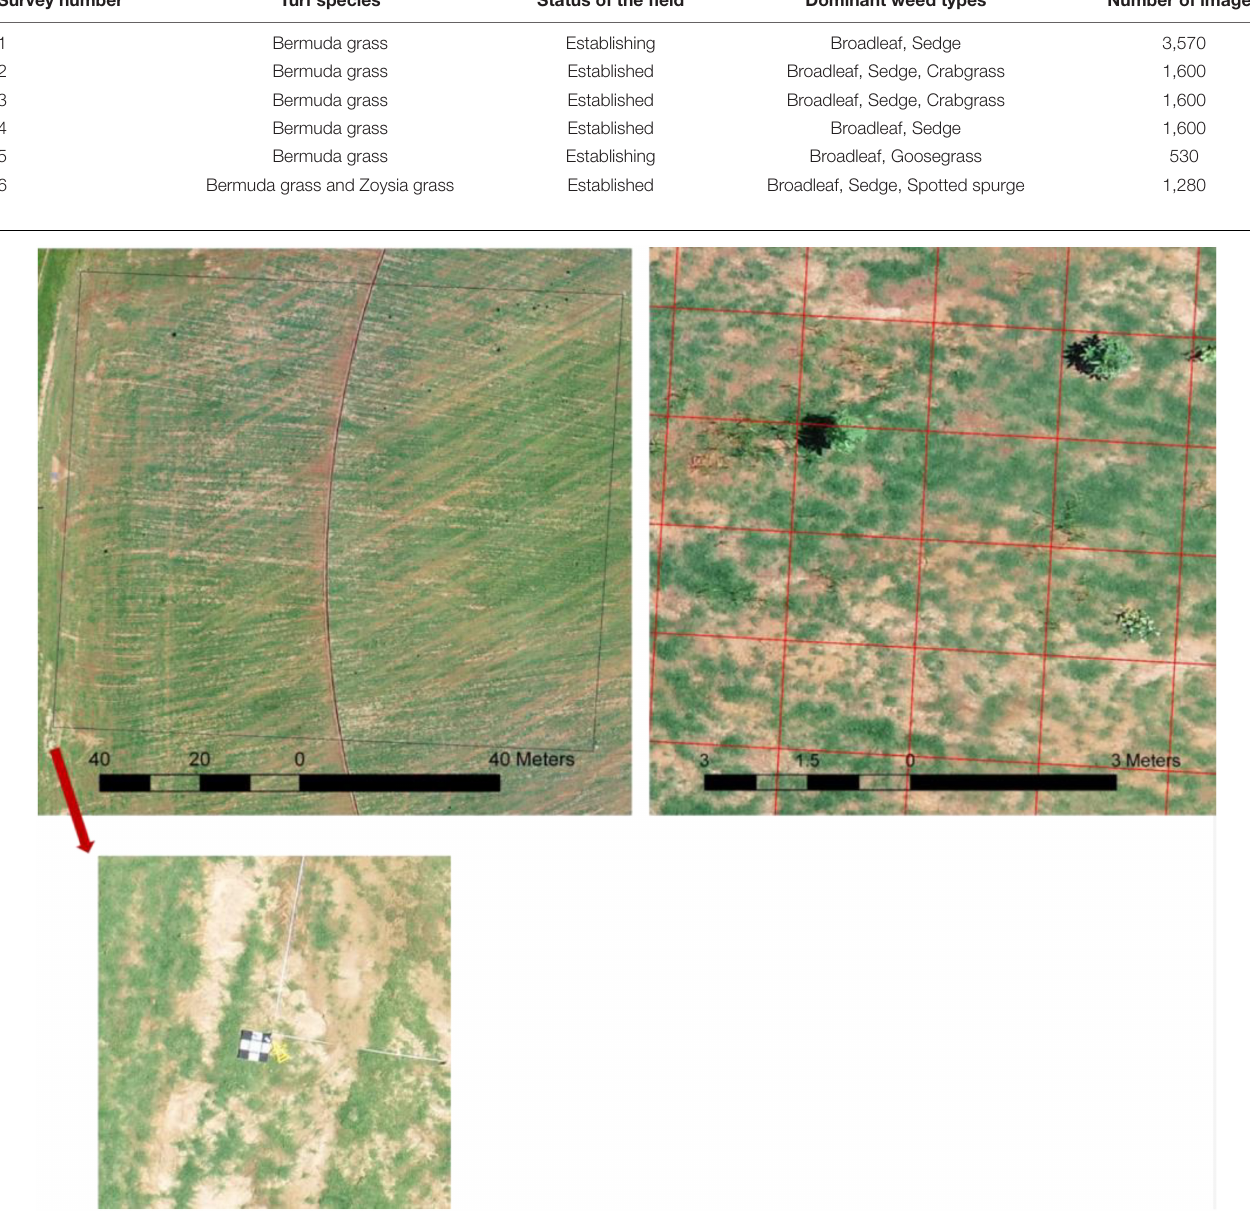
resolution was 4,864 × 3,648. The flights were conducted at 75% side and front overlap, and the flight altitudes ranged from 20 to 40 m, resulting in ground sampling distances of 0.57 cm–1.28 cm pixel − 1 . The flight times were between 10 a.m. and 4 p.m. with varying light conditions (clear, overcast, and partially cloudy). The flight plans were preprogrammed using DroneDeploy (DroneDeploy, Inc., San Francisco, CA, United States), which sets up the flight parameters such